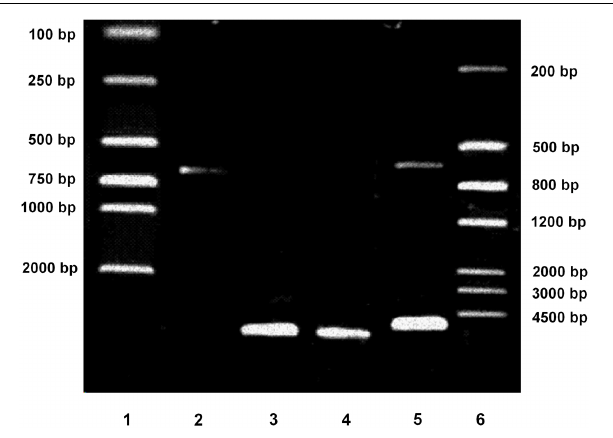
FIGURE 1 | Verification of pGL3-Enhancer-PPAR γ 2 (625 bp)-Luc plasmid by electrophoresis. Lane 1: DNA marker DL2000. Lane 2: Inserting